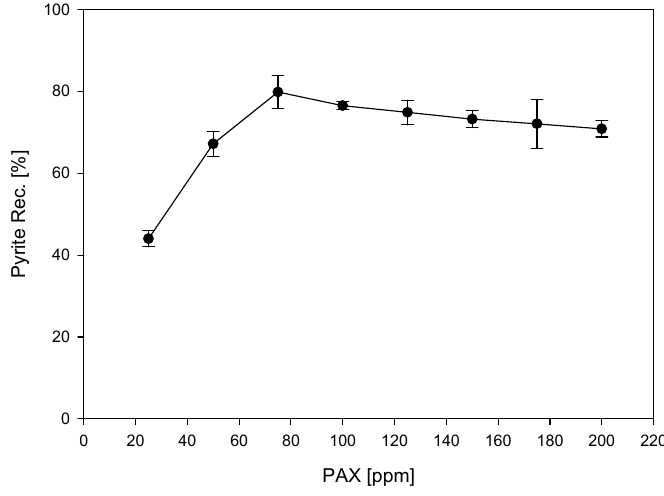
Figure 3. Pyrite recovery as a function of PAX concentration (pH 8, 20 ppm of MIBC).